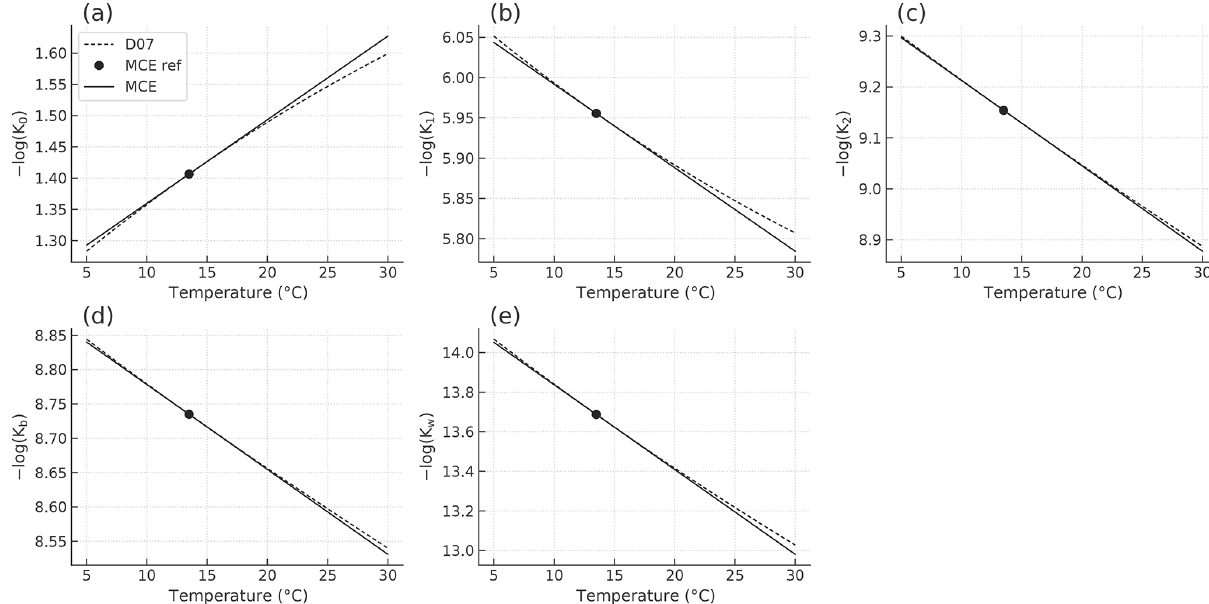
Figure 5. Temperature-dependent equilibrium constants of K 0 , K 1 , K 2 , K b , and K w (a–e) in the MCE model (solid lines), which approx- imate empirical expressions in Dickson et al. (2007) (D07, dotted lines). Values at a reference seawater temperature of 13.5 ◦ C (dots) are assigned to those in the MCE’s preindustrial state.